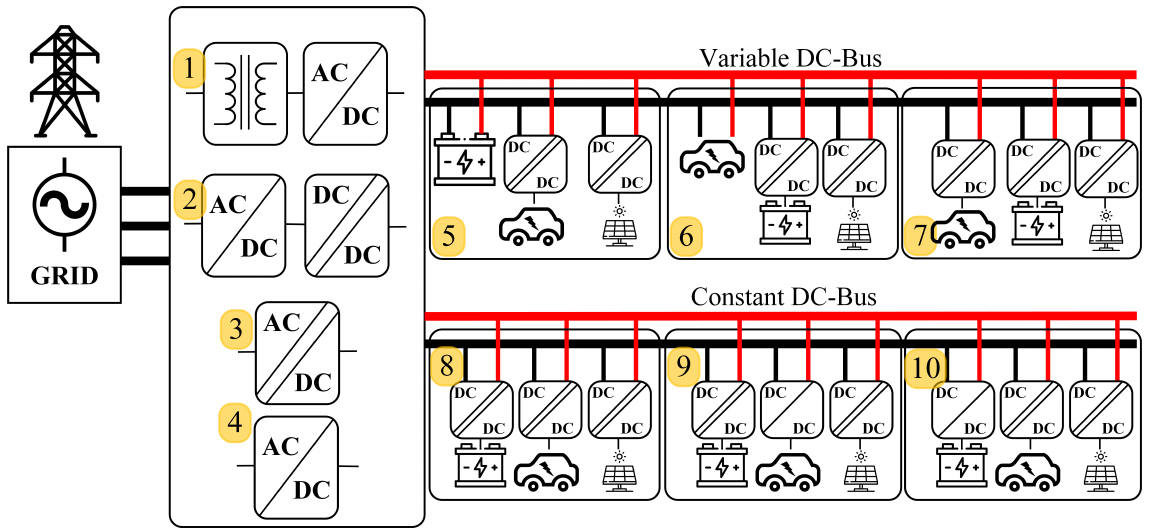
Figure 3. Architecture of a DC-Fast charger with BESS for different cases. Not all cases are compatible with each